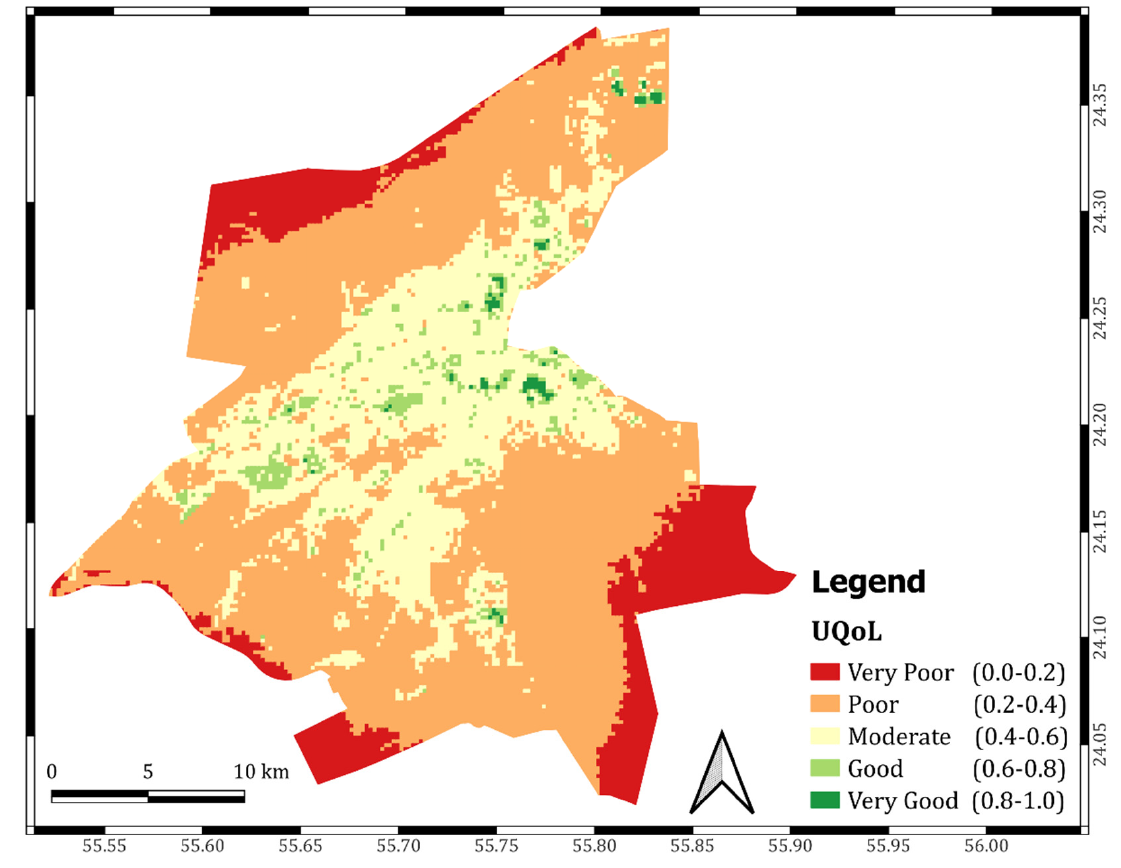
Figure 6. Urban quality of life index for Al Ain city.